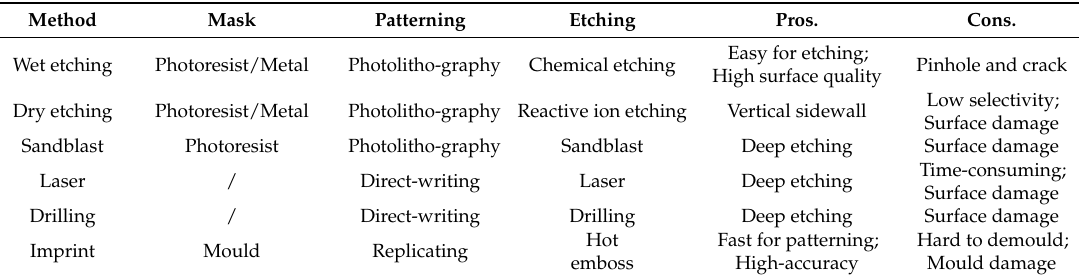
Table 1. Structure micromachining methods for